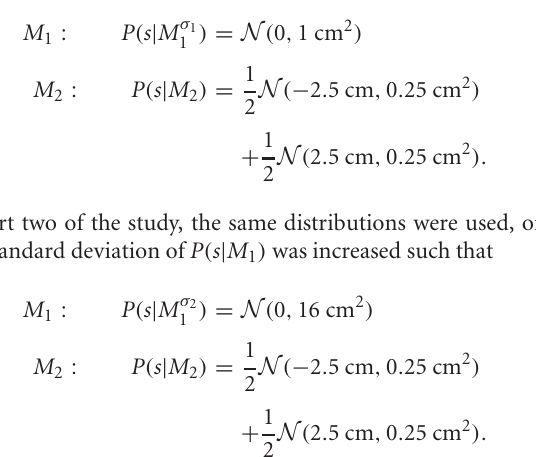
position (gray sphere, semi-transparent, radius 0 . 9 cm) to one of two target blocks (yellow cuboids, height 5 cm, width 2 cm)—see Figure 1A . One of the target blocks was in the upper half of the workspace, the other target block was in the lower half—with a distance of 2 cm in-between. Both target blocks were presented at a depth of 18 . 5 cm with respect to the start position. Once the cursor had left the start position, it was invisible and an additive random shift was applied to the cursor position. The shift was drawn from a distribution P ( s | M ) once M had been sampled from P ( M ) . The correct target was determined by the sampled M , that is the upper target was correct if M = M 1 and the lower target was correct if M = M 2 . While the cursor was invisible during the movement, after a movement depth of 5 . 5 cm visual feedback (red rectangle, width 0 . 8 cm, height 0 . 3 cm) of the shifted cursor posi- tion was displayed for 100 ms. When the movement exceeded a depth of 18 . 5 cm the trial ended. If the cursor was in-between the two targets without touching either of them, the trial continued until one of the targets was chosen. For hitting a target, the cursor had to at least touch the target block. When participants hit the correct target, a high-pitch beep was played. When participants hit the wrong target or missed the correct target, a low-pitch beep was played. In either case the incorrect target disappeared. At the end of the reach, the shifted cursor position was shown. If move- ment was still in progress after 2 s, the trial was aborted and had to be